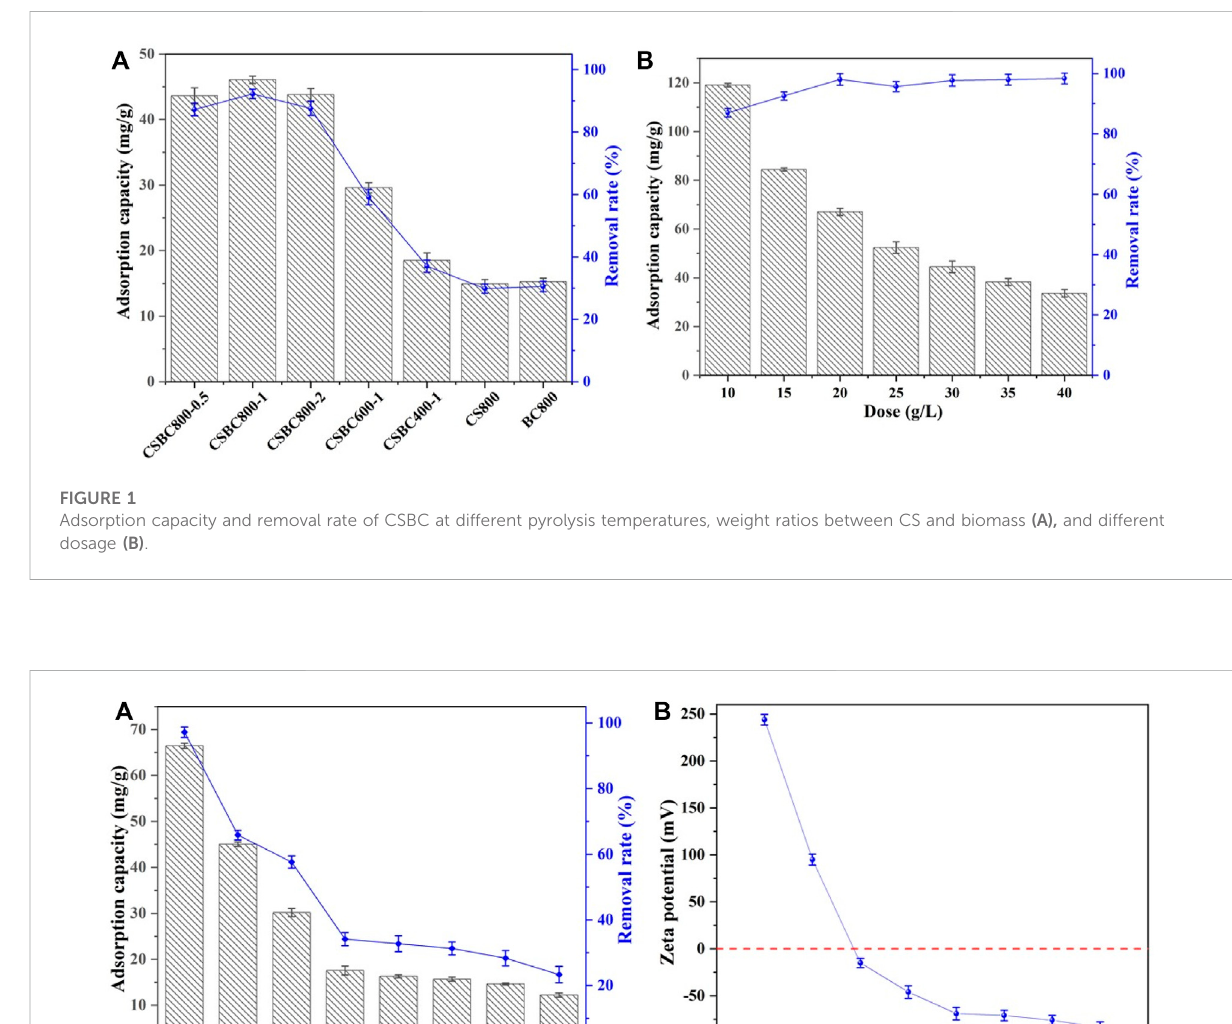
Figure 2. The removal capacity of Se(IV) by CSBC was decreased from 66.47 mg/g at pH 2 to 12.23 mg/g at pH of 9. This could be attributed to the better electron shuttling effects of Fe 0 species under acid conditions (Liu et al., 2022). Moreover, the surface zeta potential of CSBC was tested (see Supplementary Data), and the pH ZPC of CSBC was 3.91. When the solution ’ s pH moved beyond pH zpc , the surface was charged, and the anionic Se(IV) and sorbent surface repelled one another. This reduces the ef fi ciency of Se(IV) elimination. When it decreased below pH zpc , the positive charge became a negative charge, which admirably adsorbs the cationic Se(IV) molecules (Osman,